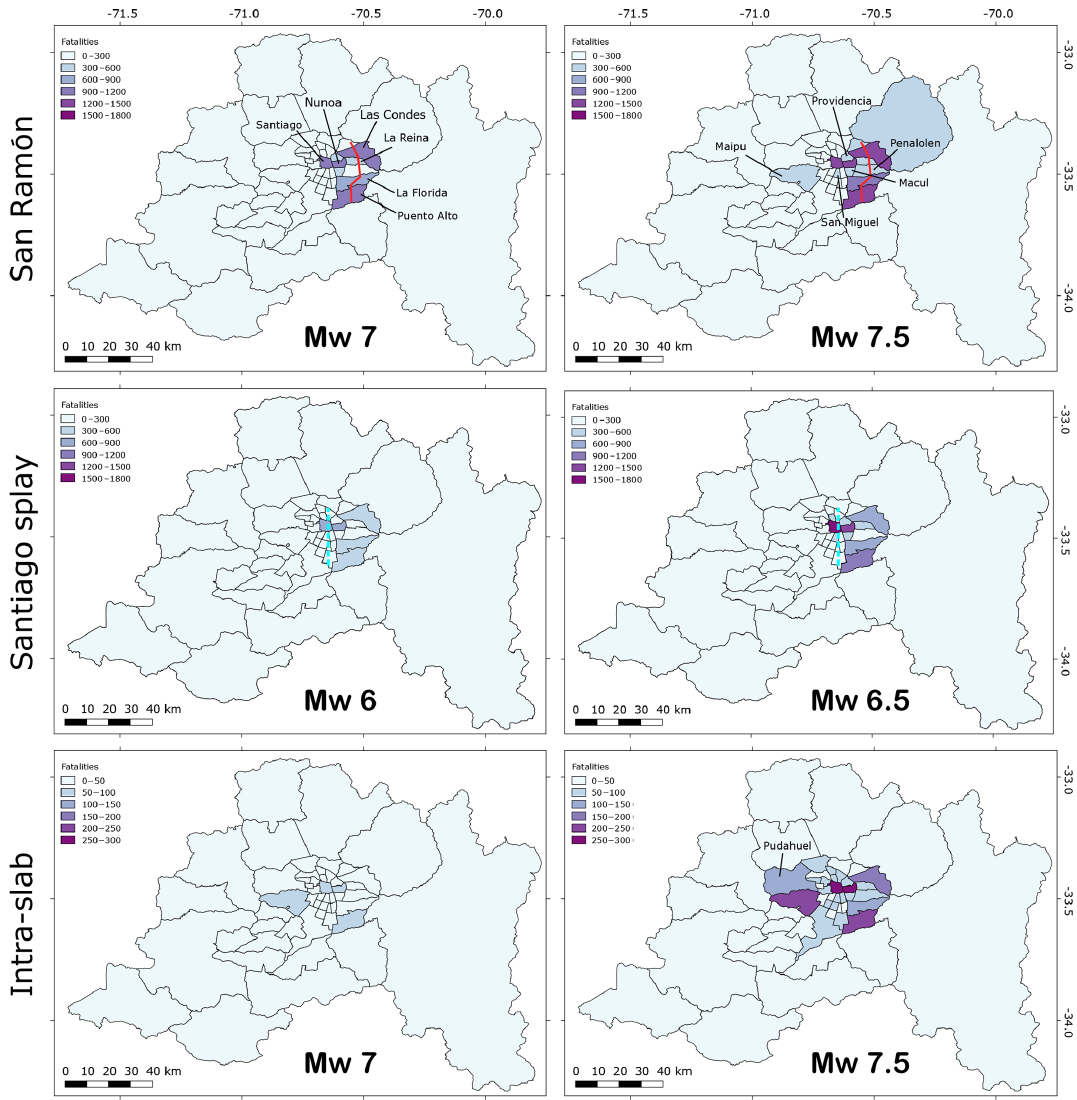
Figure 12. The estimated fatalities in each commune for the earthquakes considered in each scenario for the San Ramón Fault (red line), the Santiago splay fault (dashed cyan line), and a deep intra-slab fault. Note that the range of the colour scale changes between the upper four and lower two